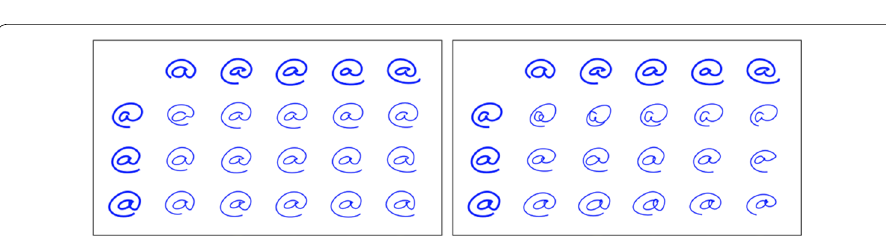
Fig. 14 Examples of interpolated instances in the feature space on the handwritten ‘@’ character